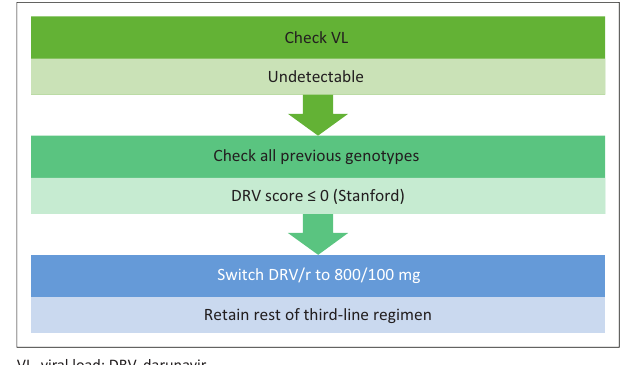
FIGURE 3: Patients initiating third-line antiretroviral therapy.